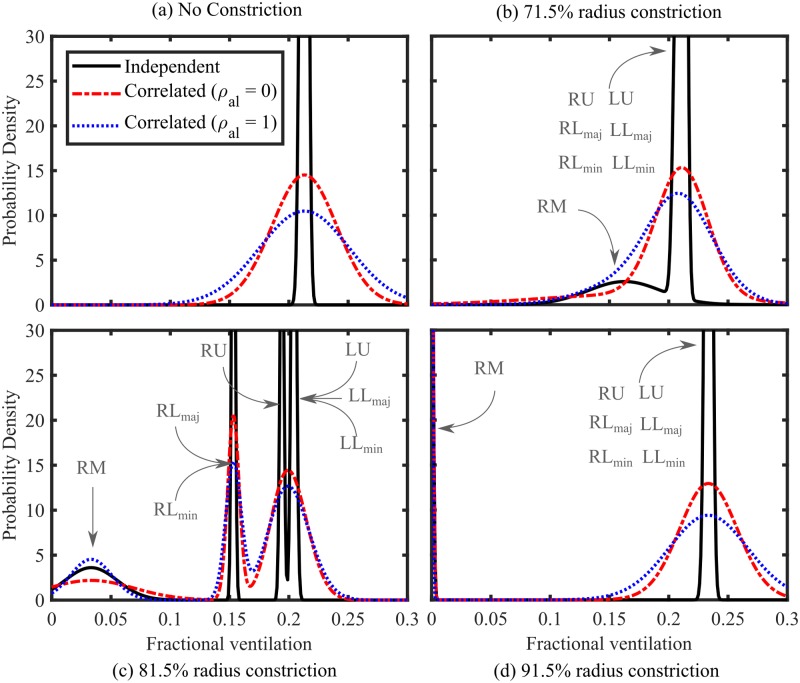
Whole lung FV distributions for (a) 0% (b) 71.5% (c) 81.5%, and (d) 91.5% constrictions to the radius of the airways in the central airways of the RM lobe (central, Strahler orders 15-12) from model P.Results for independent random perturbations (solid black lines) and structurally correlated random perturbations with ρal = 0 (dashed red lines) and ρal = 1 (fixed diameter-length ratio, dotted blue lines). σa = 0.2 and σl = 0.1 was used in all cases. In (b), (c) and (d) the peaks are labelled by their corresponding region(s) as denoted in Fig 1. For visibility, the y-axis range does not extend to include all of the peaks.